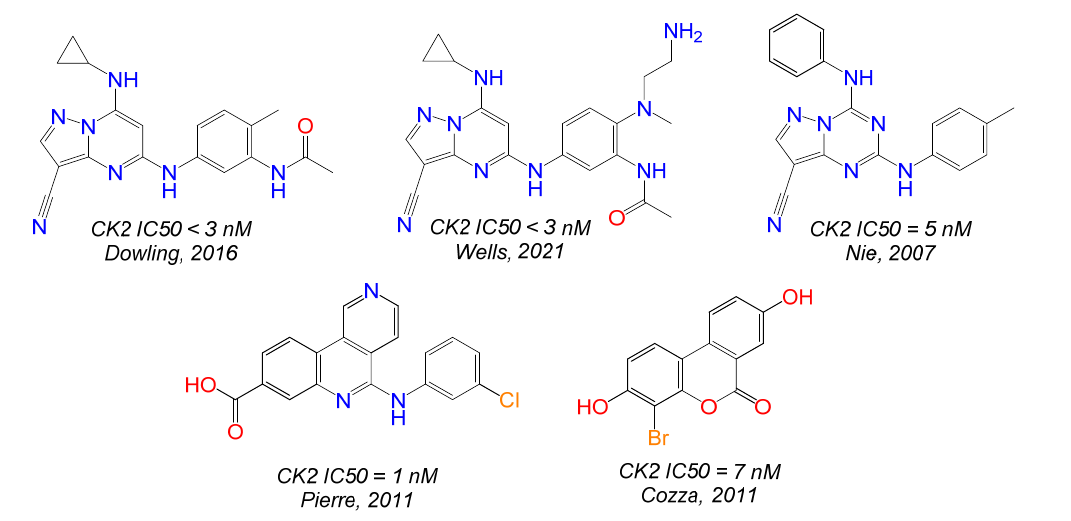
Figure 1. Examples of pyrazoloazines and other molecules with high affinity for CK2 [11–15].